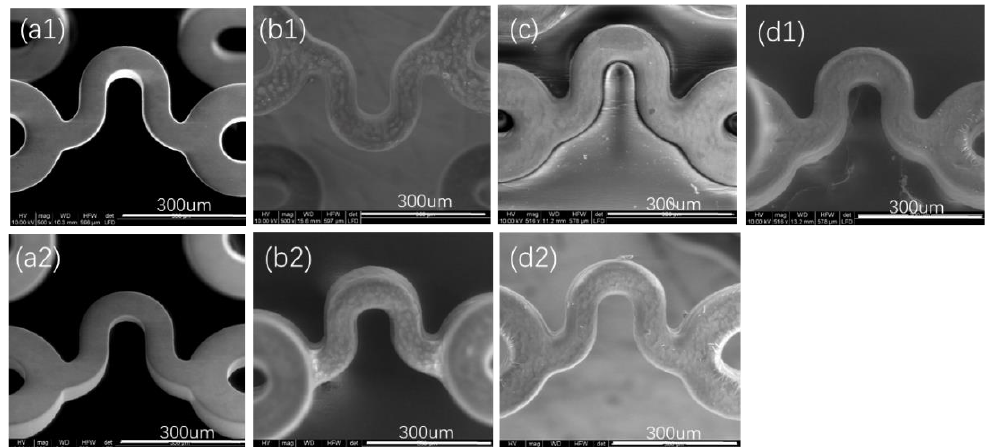
Figure 3. Morphologies of coating surfaces made by P34HB-1. ( a1 ) Outer surface of a bare stent; ( b1 ) outer surface of a drug stent; ( c ) outer surface of a drug stent at squeezed state; ( d1 ) outer surface of a drug stent after expansion; ( a2 ) inner surface of a bare stent; ( b2 ) inner surface of a drug stent; ( d2 ) inner surface of a drug stent after expansion.